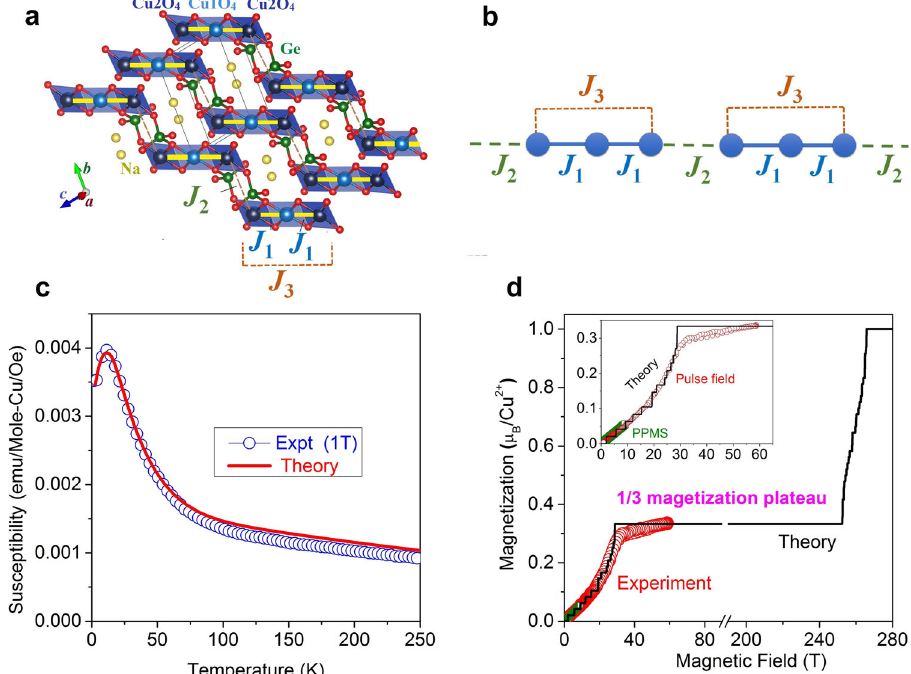
Fig. 1 | Crystal structure, magnetic model, magnetic susceptibility, and fi eld- dependent magnetization of Na 2 Cu 3 Ge 4 O 12 . a The schematic spin-trimer struc- ture of Na 2 Cu 3 Ge 4 O 12 . The spins S1, S2, and S3 are the three Cu 2+ spins within a trimer unit. The J 1 , J 2 , and J 3 denote the intratrimer, intertrimer and next-nearest neighbour intratrimer exchange couplings, respectively. b The schematics of 1D spin-chainwith J 1 , J 2 (= α J 1 ),and J 3 (= β J 1 ). c Thetemperature-dependentsusceptibility ( χ v s. T ) curve (open circles) of Na 2 Cu 3 Ge 4 O 12 measured under a magnetic fi eld ( μ 0 H )=1 Tesla. The calculated susceptibility curve as per the Hamiltonian (Eq. 1) with the parameters J 1 = 235K, α = 0.18, and β = 0.18 is shown by the red solid line. ThecalculationswereperformedbyahybridED/DMRGmethodupto N =96. d The